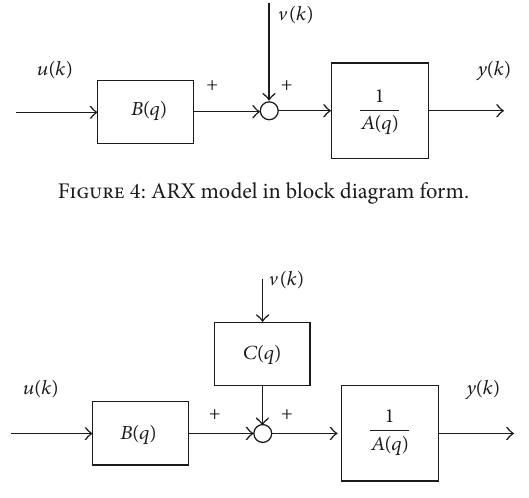
Figure 5: ARMAX model in block diagram form.